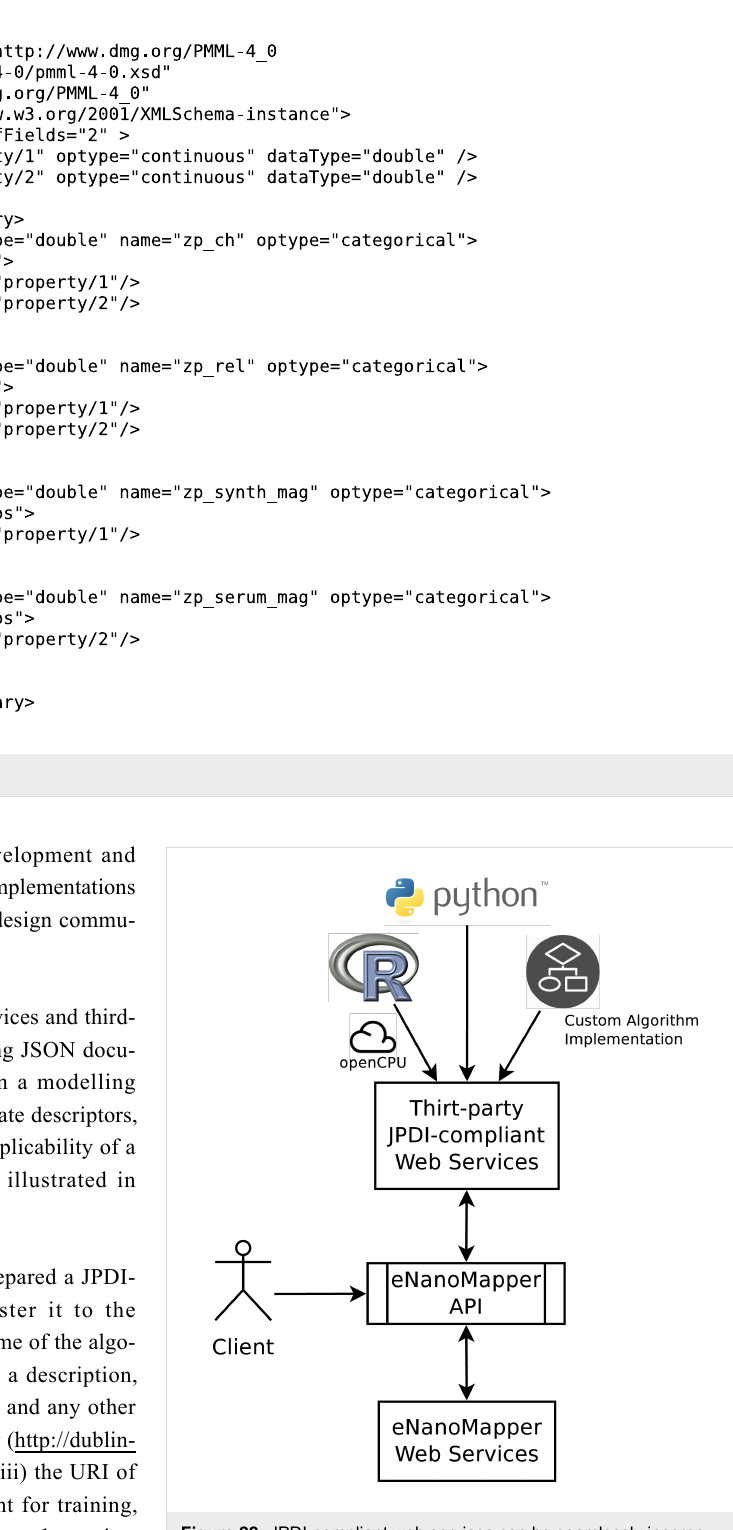
Figure 22: JPDI-compliant web services can be seamlessly incorpo- rated into the eNanoMapper framework. The client communicates with eNanoMapper services through the eNanoMapper API while certain operations such as model training are delegated to JPDI-compliant